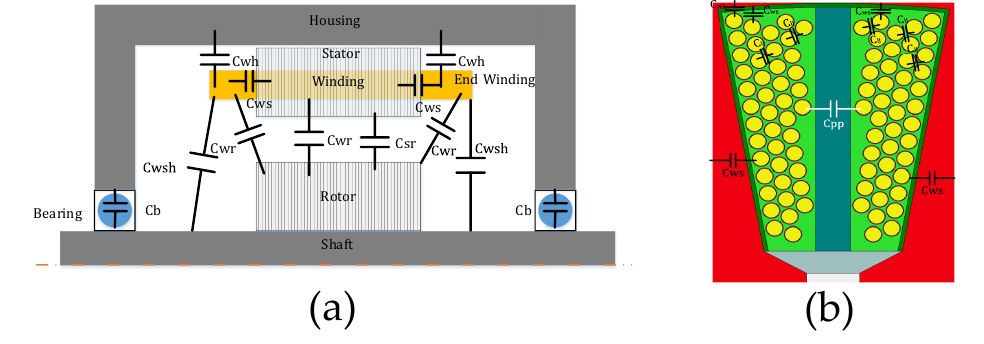
Figure 4. Parasitic Capacitances. ( a ) Motor view. ( b ) Winding